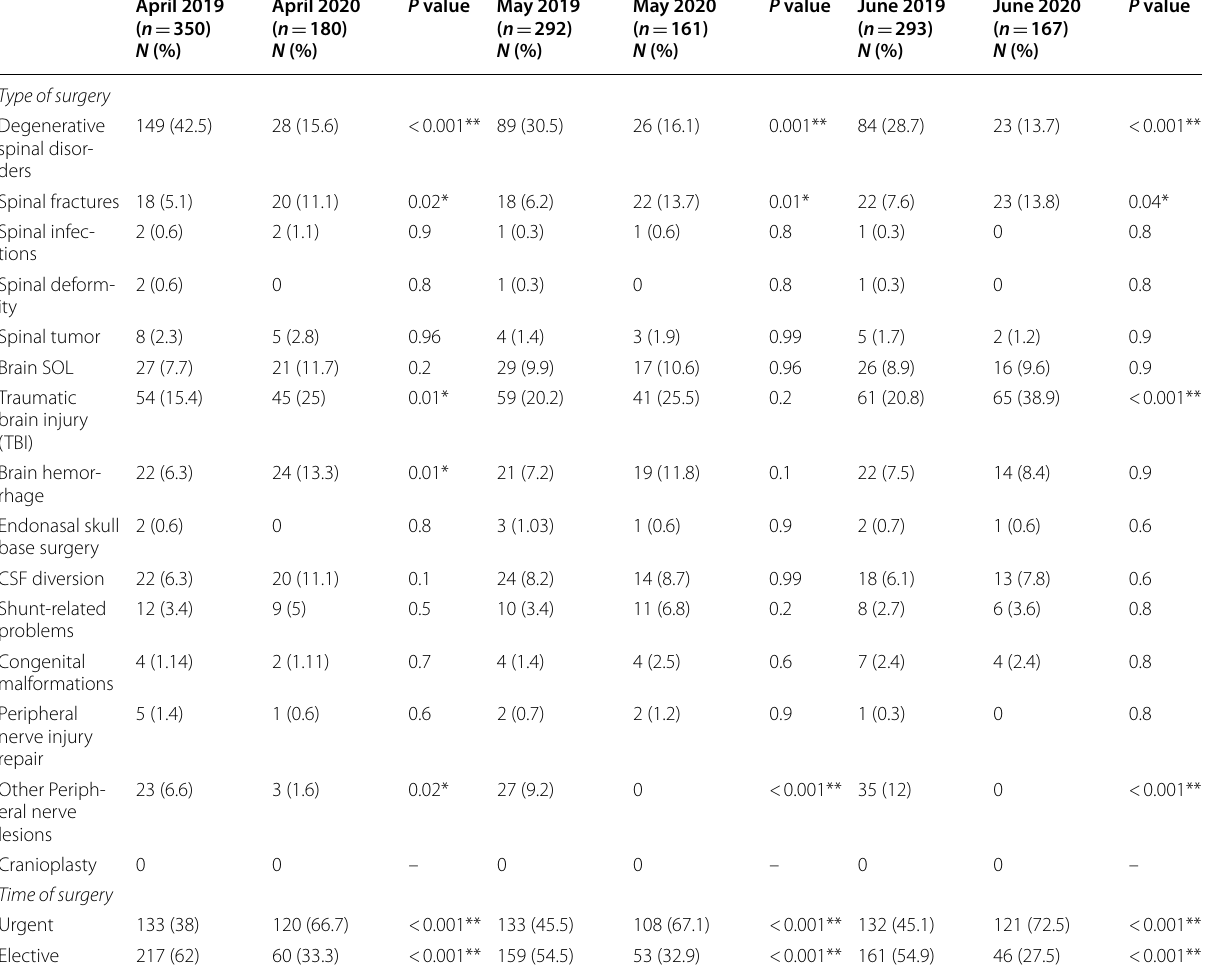
Table 4 Neurosurgical operations in the 2nd 3 months of 2019 and 2020 (April, May and